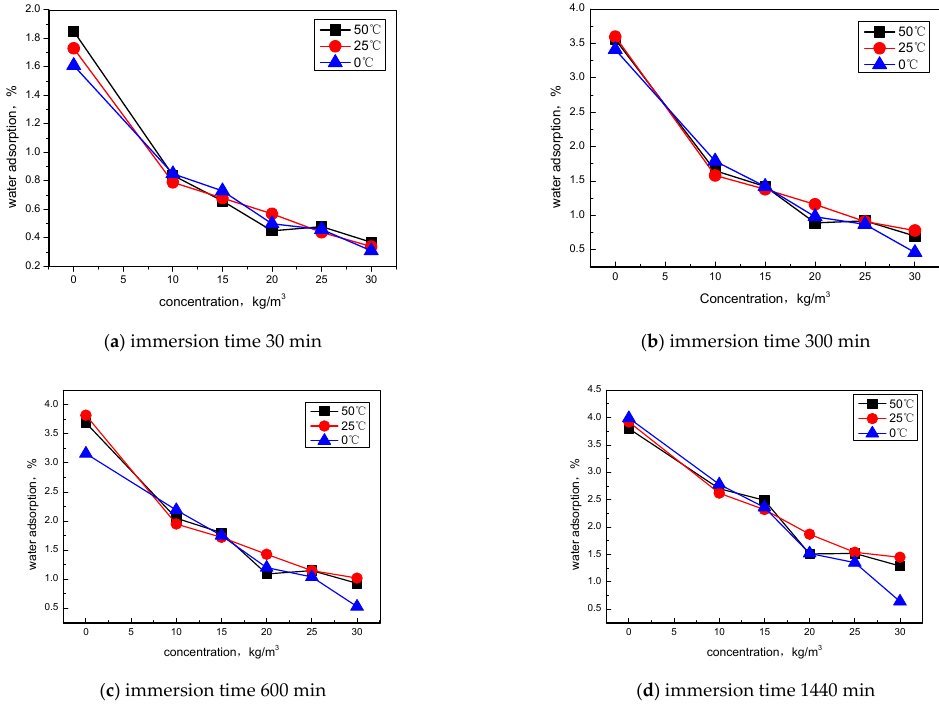
Figure 3. Water adsorption without and with different contents of TIA during different immersion times: ( a ) 30 min, ( b ) 300 min, ( c ) 600 min, and ( d ) 1440 min at environment temperatures of 0 °C, 25 °C, and 50 °C. With the prolongation of soaking time, the overall change trend of water absorption of concrete with TIA concentration does not change. The difference is that at 0 °C, the higher mixing amount of TIA will lead to more reduction in water absorption; the result shows that the water absorption ratios all decrease with the concentration of TIA increasing at different environment temperatures, while the influence of temperature on water adsorption was less. Figure 4 is the water evaporation ration of concrete treated with and without TIA at different contents of TIA, immersion times, and environment temperatures. The results in Figure 4a–c show that temperature has a great influence on the rate of water evaporation at the initial drying stage. The lower the temperature is, the lower the rate of water evaporation. At high temperature, the water evaporation rate is faster. After long-time exposure, the effect of temperature on the water evaporation rate gradually decreases, such that after 5760 min of exposure (Figure 4d) the water evaporation rate at different temperatures gradually approaches.